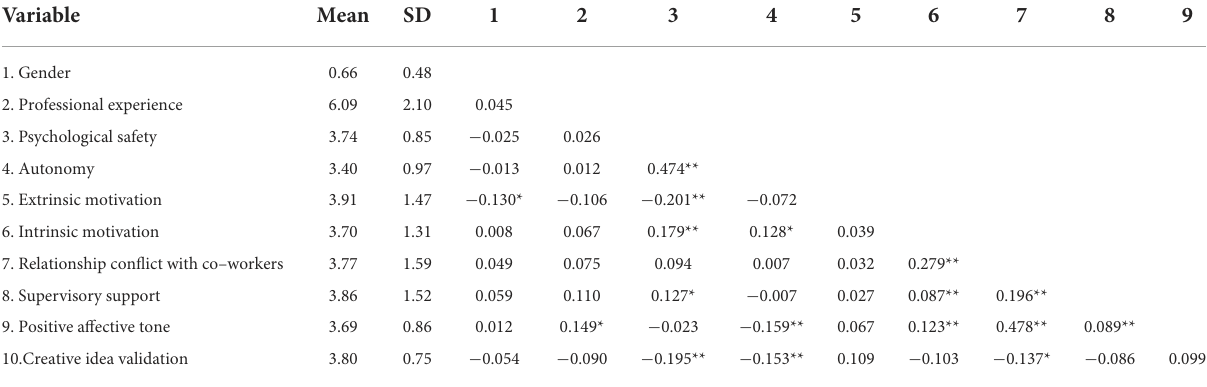
TABLE 1 Means, standard deviation, and correlation among study variables.